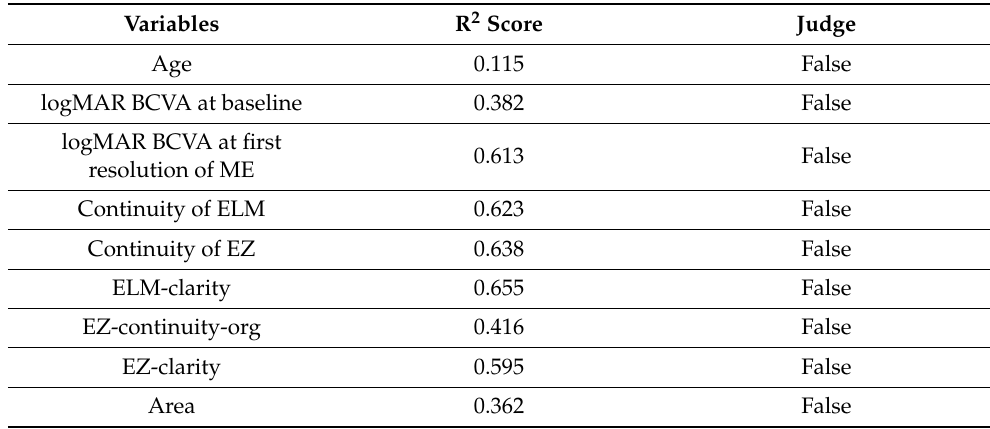
Table 3. Evaluation of